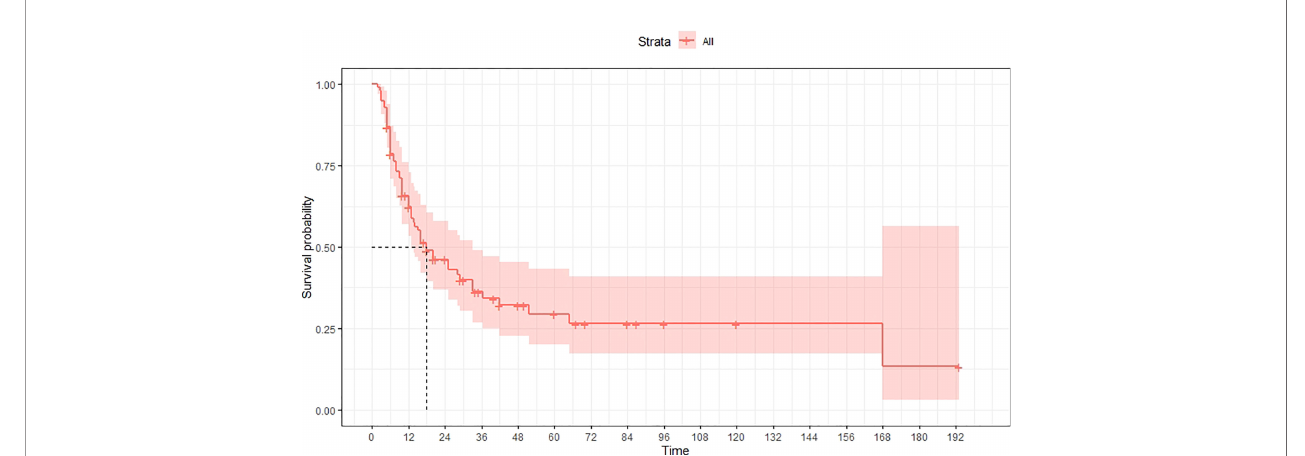
FIGURE 2 | Kaplan – Meier survival curves for OS of patients. The median OS was 18 months.